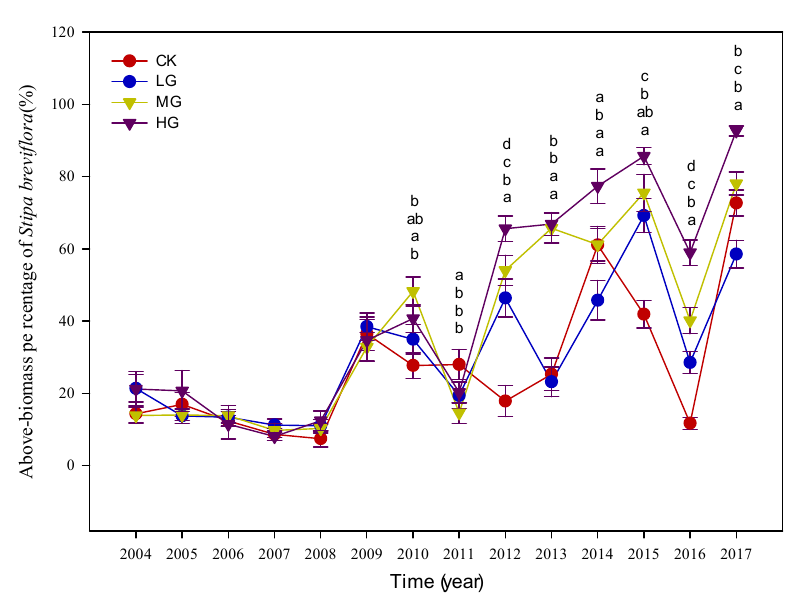
Time:198.431*** Stocking rate:44.475***